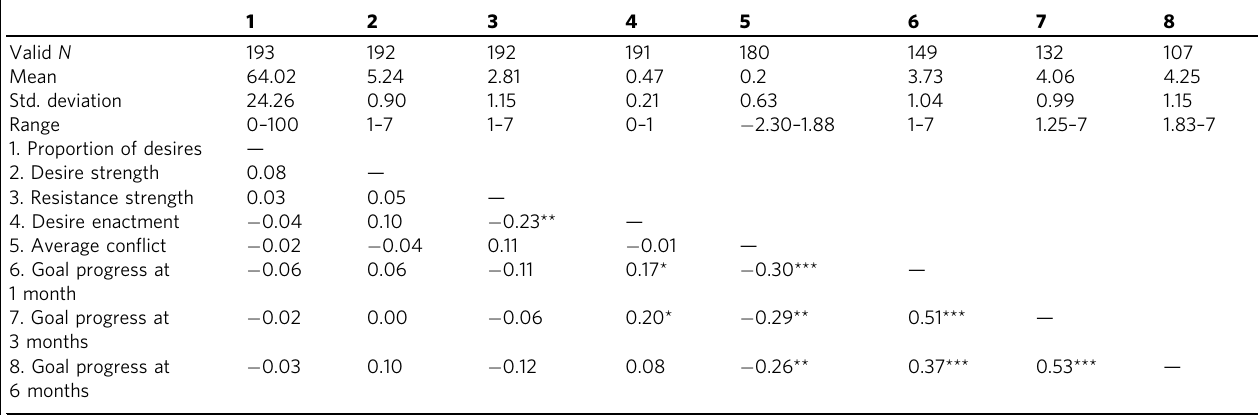
Table 2 Descriptive statistics and correlations for experience sampling and goal progress